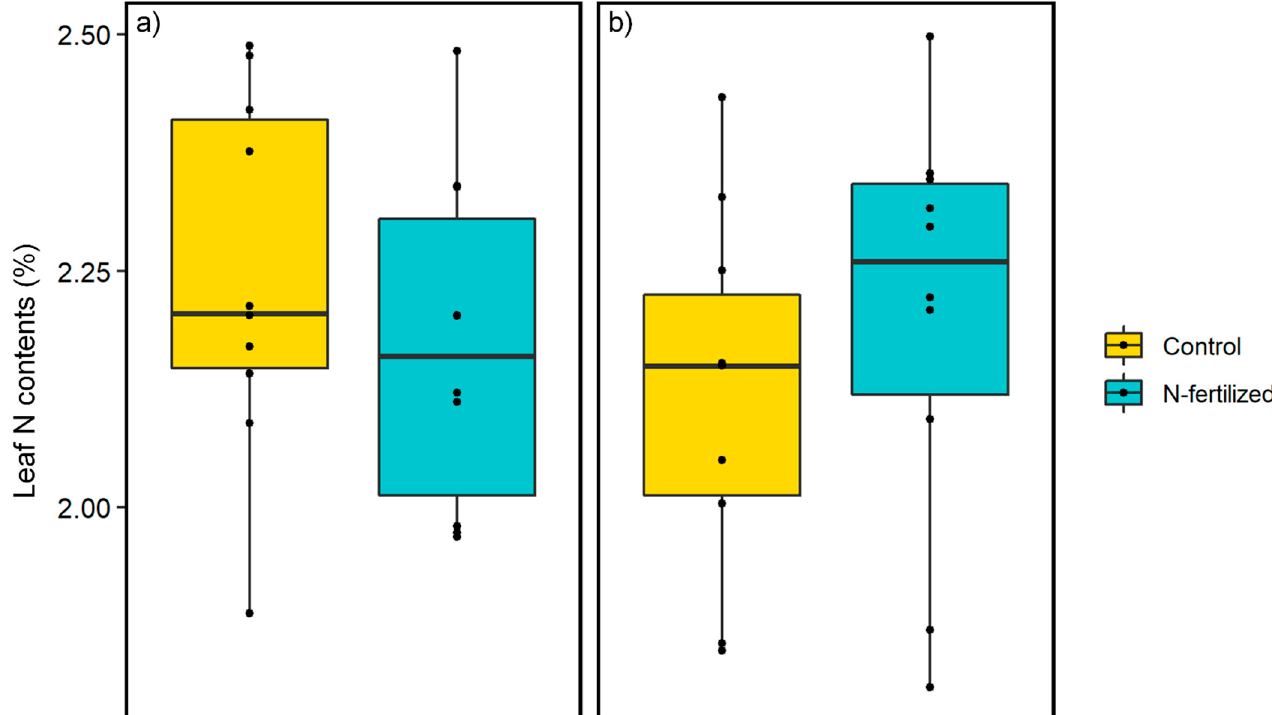
Figure 6. ( a ) Tree leaf N contents before fertilization in July and ( b ) after fertilization in September ( n = 10). The upper end of the line means the maximum. The upper end of the box means the first quartile. The center line of the box means the median. The lower end of the box means the third quartile. The lower end of the line means the minimum. The black circles indicate raw data points. The yellow boxes indicate the data in the control plot, and the light blue boxes indicate the data in the N-fertilized plot. No significant difference was found between the control and the N-fertilized before and after N-fertilization ( p > 0.05, t